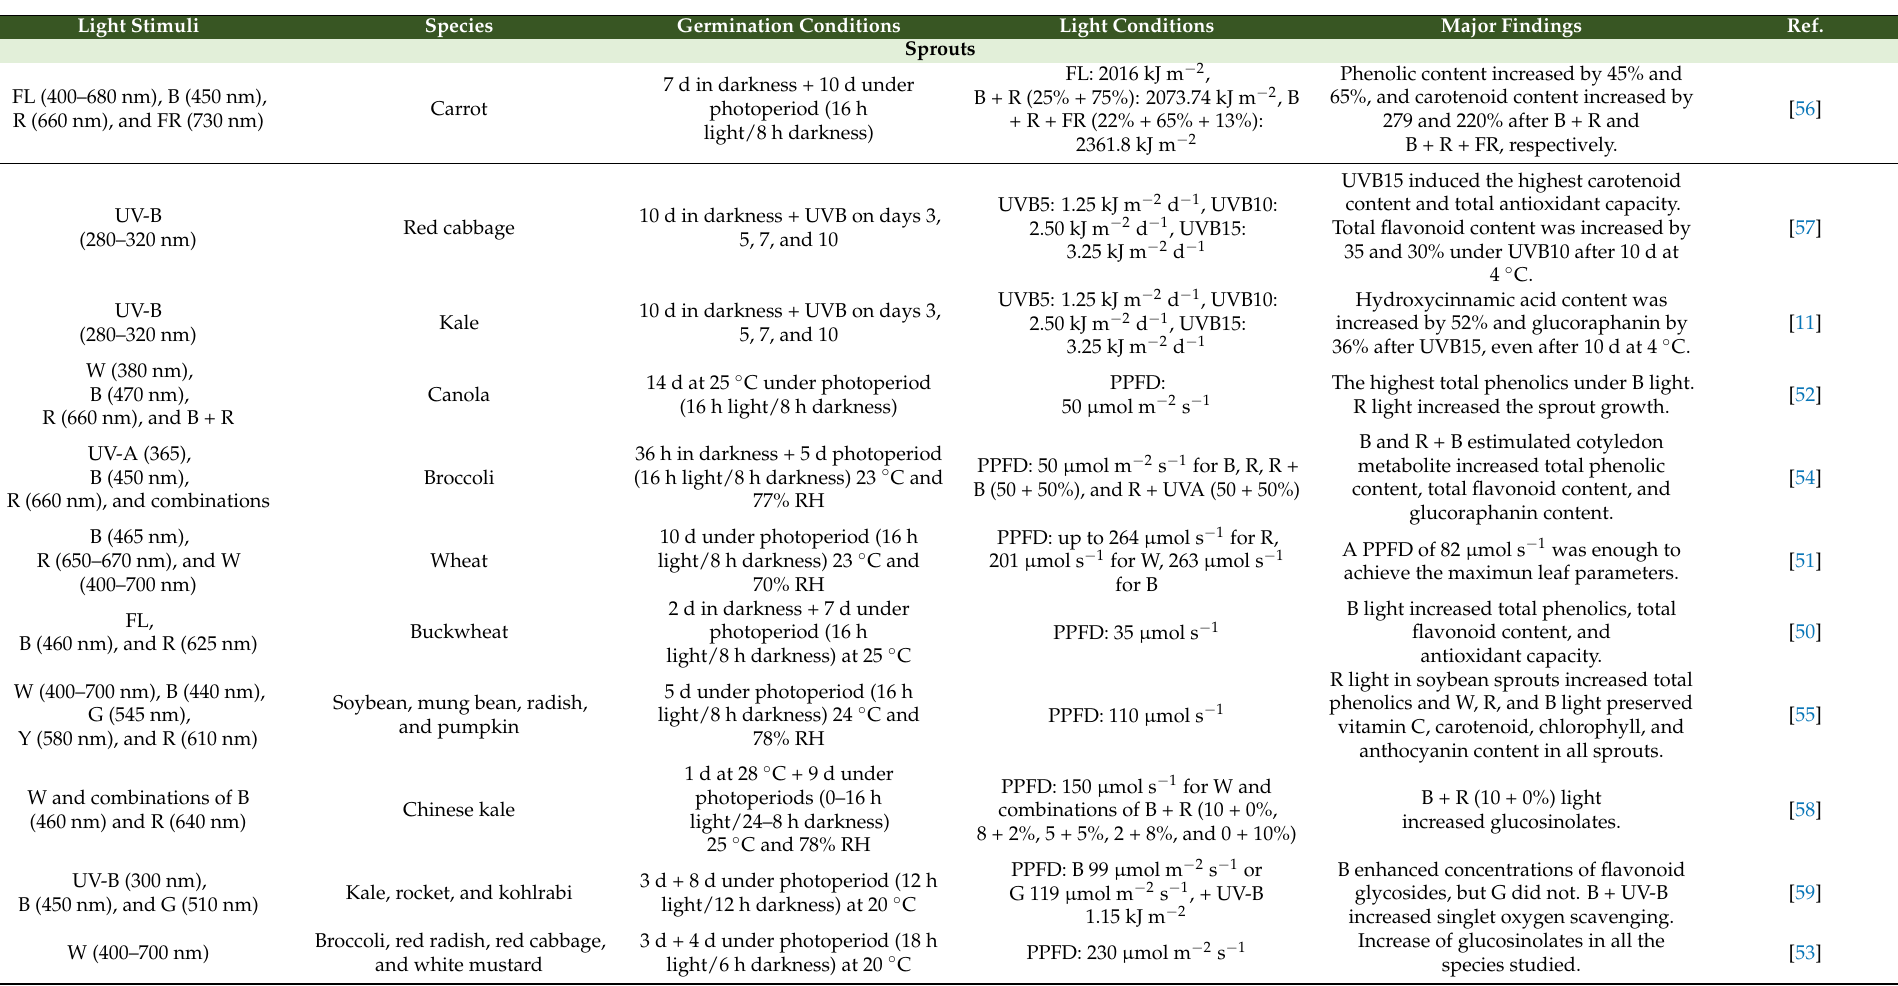
Table 1. Recent most relevant preharvest UV and visible spectrum lighting as phytochemicals elicitors in sprouts, microgreens, and baby